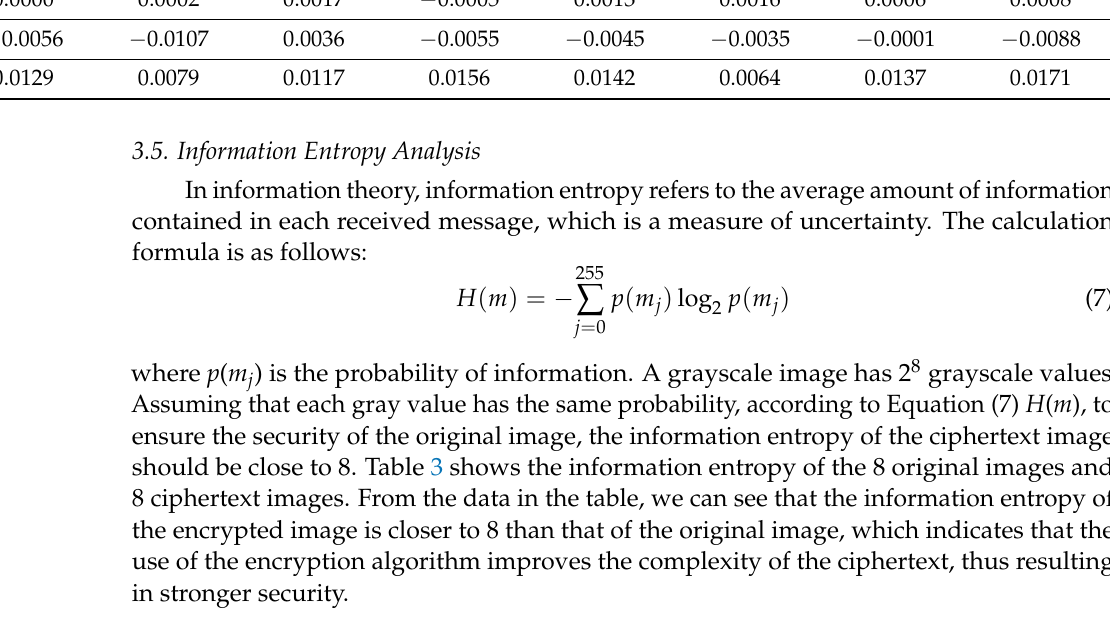
Table 3. The information entropy of the four original images and four ciphertext